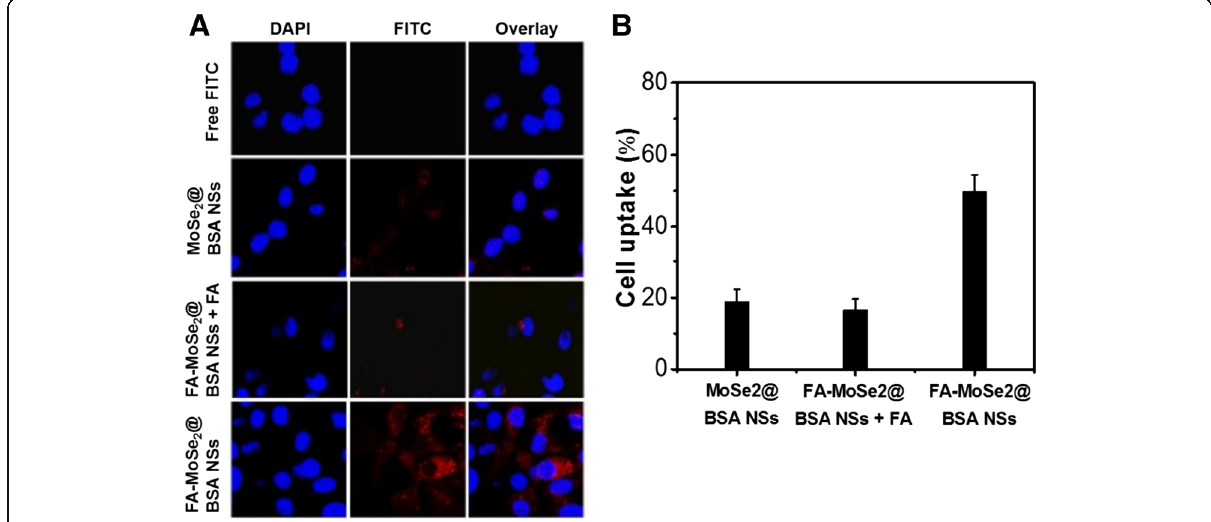
Fig. 3 a Confocal fluorescence images of 4T1 cells after incubation with free FITC, and FITC-labeled MoSe 2 @BSA NSs, FA-MoSe 2 @BSA NSs + FA blocking, and FA-MoSe 2 @BSA NSs. Red and blue colors represent FITC fluorescence and DAPI stained cell nuclei, respectively. b ICP-AES quantitative analysis of 4T1 cells toward MoSe 2 @BSA NSs, FA-MoSe 2 @BSA NSs + FA blocking, and FA-MoSe 2 @BSA